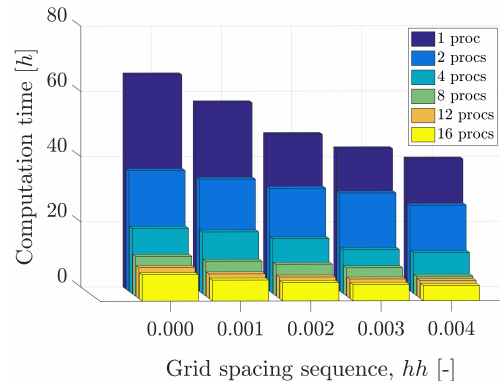
Figure 5. Computation time as a function of the number of pro- cessors concurring to the computations (domain decomposition along the wind direction) and the grid spacing sequence hh for the wind scheme (vertical direction).